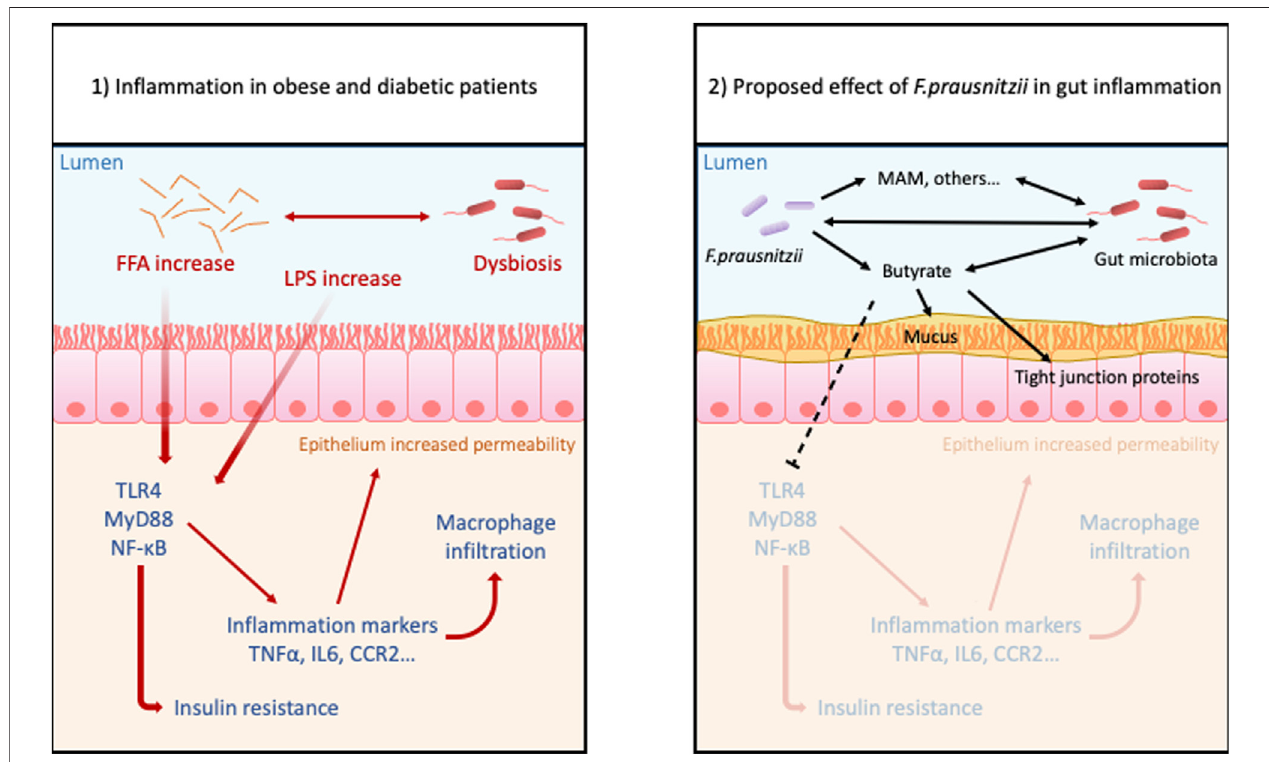
FIGURE 2 | Proposed bene fi ts effects of Faecalibacterium prausnitzii in gut in fl ammation due to obesity: Obesity and hyperglycemia cause dysbiosis, increased level of FFA and LPS, and also disrupts intestinal permeability. These conditions trigger in fl ammatory pathways in the lamina propria allowing more permeability to antigens and bacteria. This leads to a leaky gut and susceptibility to in fl ammatory disorders. The treatment with probiotic F. prau and its products can increase the butyrate concentration, stabilizes the microbiota and mucous layer and decreases the activation of in fl ammatory pathway.